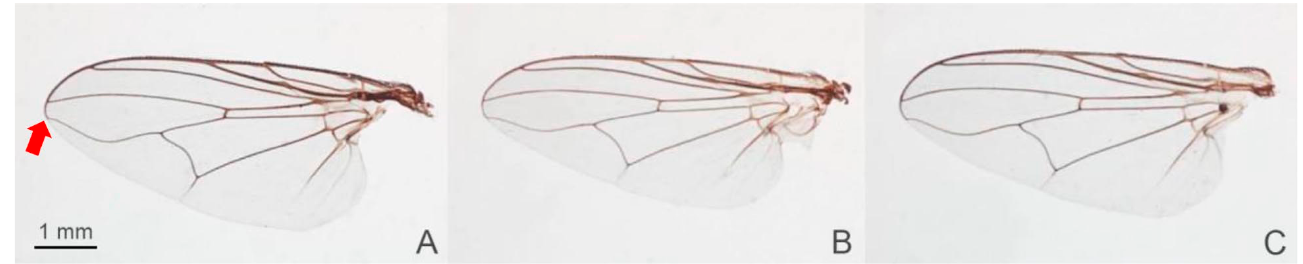
Figure 3. Wings of Stomoxys bengalensis ( A ), S. calcitrans ( B ), and S. sitiens ( C ). Stomoxys bengalensis is distinguished from S. calcitrans and S. sitiens by wing with the apex of media almost directly under the apex of r 4+5 (arrow). Photos are made by authors.